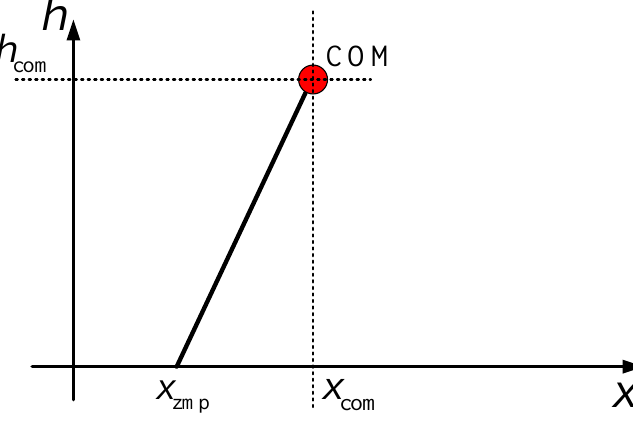
Figure 4. Linear inverted pendulum of the robot.